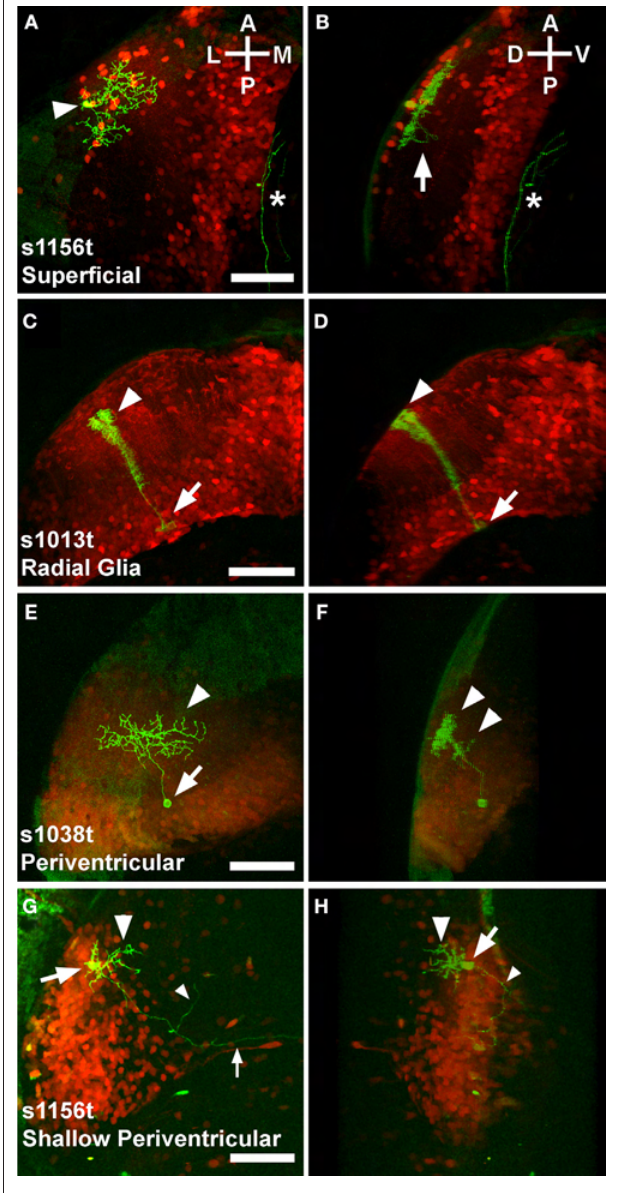
FiGUrE 4 | Variegated UAS:mGFP reveals single cell types in the larval tectum. Panels show Gal4 expression patterns in red (photoconverted Kaede), and individual neurons in green (mGFP). Each pair of panels [e.g. (A) and (B) ] comprises a dorsal view showing the structure in the A/P and M/L axes (A) and a rotated image that illustrates the D/V extent of the neuron (B) . Superficial neurons have neurites spreading away from the cell body [arrowhead, (A) ] in the A/P and M/L axes. The arbor is highly stratified to a dorsal layer of the neuropil, probably the SO (B) , with a single extension, possibly an axon, crossing into a deeper layer, probably the SFGS [arrow, (B) ]. An unrelated neurite is also visible [asterisk in (A) and (B) ]. Cells with structures typical of radial glia have cell bodies in the ventral periventricular layer [arrow, (C) ], and a bushy dorsal extension that passes through the neuropil [arrowhead, (C) ]. These cells invariably extend from their cell body at the ventricular boundary [arrow, (D) ] to the extreme dorsal edge of the neuropil [arrowhead, (D) ]. Periventricular neurons have their cell bodies in the periventricular layer [arrow, (E) ], and extend dendrites into the tectal neuropil [arrowhead, (E) ]. These dendrites are typically but not always stratified in one or more D/V layers of the neuropil [arrowheads, (F) ]. A distinct category of periventricular neuron, the shallow periventricular neuron, is shown in (G) and (H) . Shallow periventricular neurons have cell bodies at the boundary of the cell body layer and the neuropil [arrows, (G) and (H) ], send dendrites exclusively into deeper layers of the neuropil [arrowheads, (G) and (H) ], and have axons that extend ventrally, rostrally, [small arrowheads, (G) and (H) ] and contralaterally [small arrow, (G) ] to targets beyond the tectum. All scale bars represent 50 μm, and apply to both panels in a pair. Orientations are approximate. Animals are 5 or 6 dpf, and are heterozygous for the indicated Gal4 insertion, UAS:Kaede , and BGUG